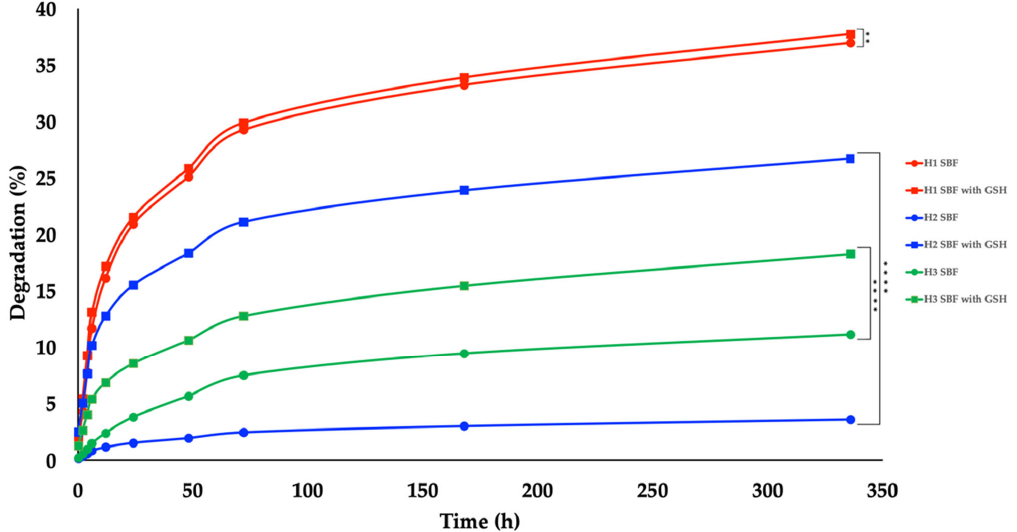
Figure 5. Degradation profiles of H 1 , H 2 , and H 3 SNPs over 14 days in simulated body fluid (SBF) or SBF with 10 mM glutathione (GSH) (pH 7.4) incubated at 37 °C. Silicon values were measured by ICP ‐ MS in triplicate. H 2 nanoparticles demonstrate higher resistance to degradation in SBF alone compared to H 1 and H 3 nanoparticles due to the increased composition of the hydrophobic disulfide ‐ bridged silsesquioxane framework resulting in slower hydrolysis. H 3 nanoparticles were observed to have the least degradation in SBF with 10 mM GSH due to a reduction in solvent/particle inter ‐ actions within the deeper layers and core of the nanoparticle. The results are plotted as means ± SD of three independent experiments (** p value < 0.01, **** p value < 0.0001).